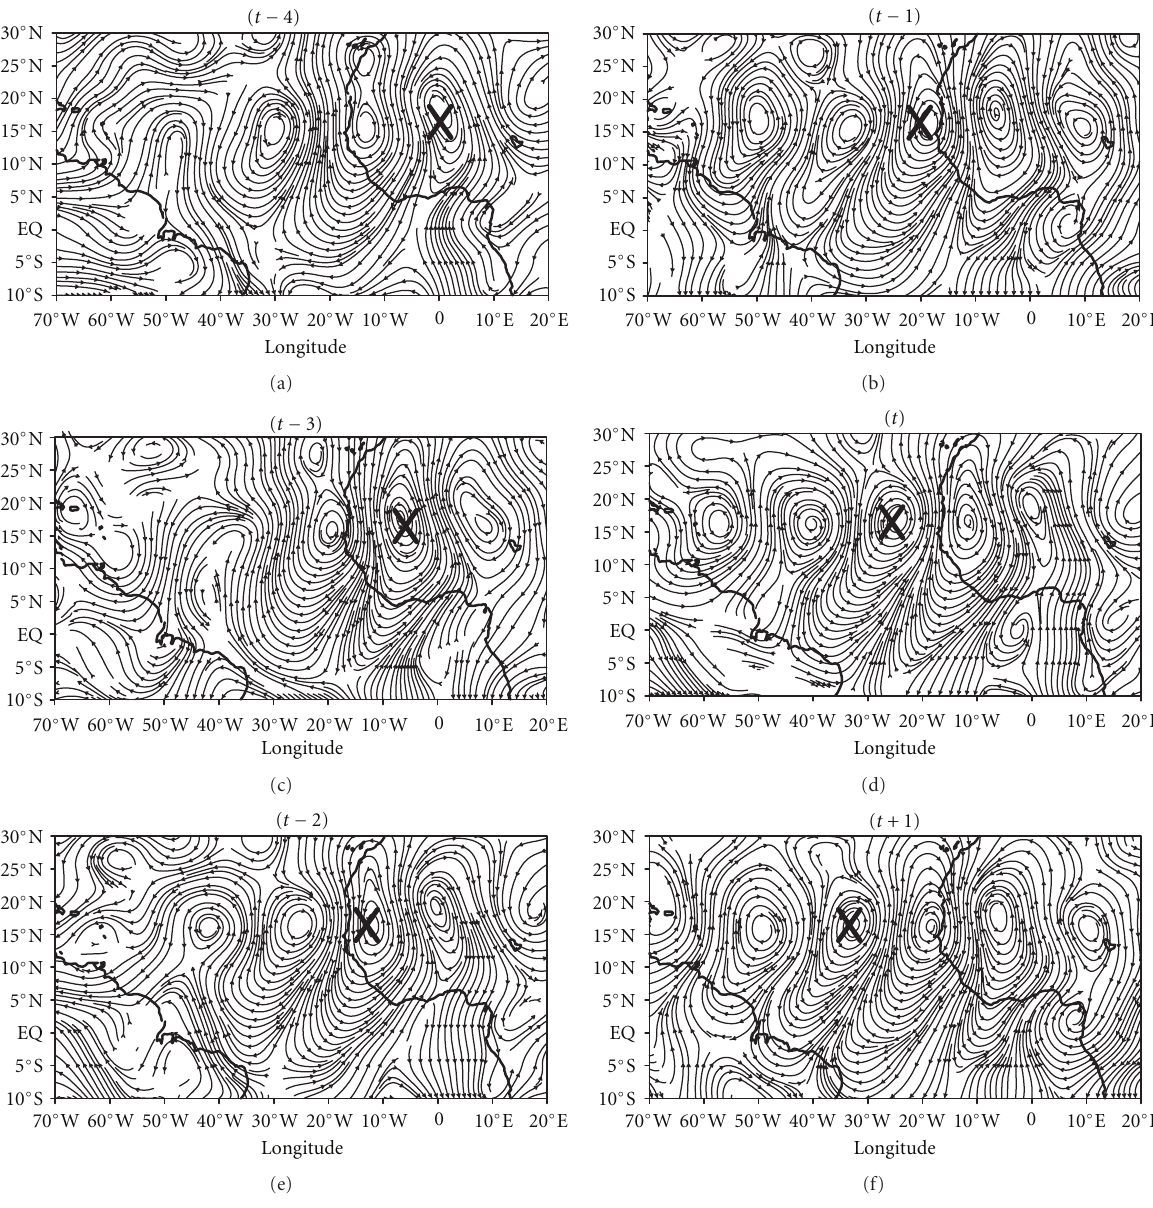
Figure 3: Streamlines at 700 hPa for the 48 AEWs not associated with cyclones. The time sequence ( t − 4, t + 1) considered in this study is from 4 days before to 1 days after the detection of AEWs at the mean genesis longitude for the 48 cyclones (30 ◦ W). T represents the detection time of AEWs at this mean longitude. X represents the location of AEWs